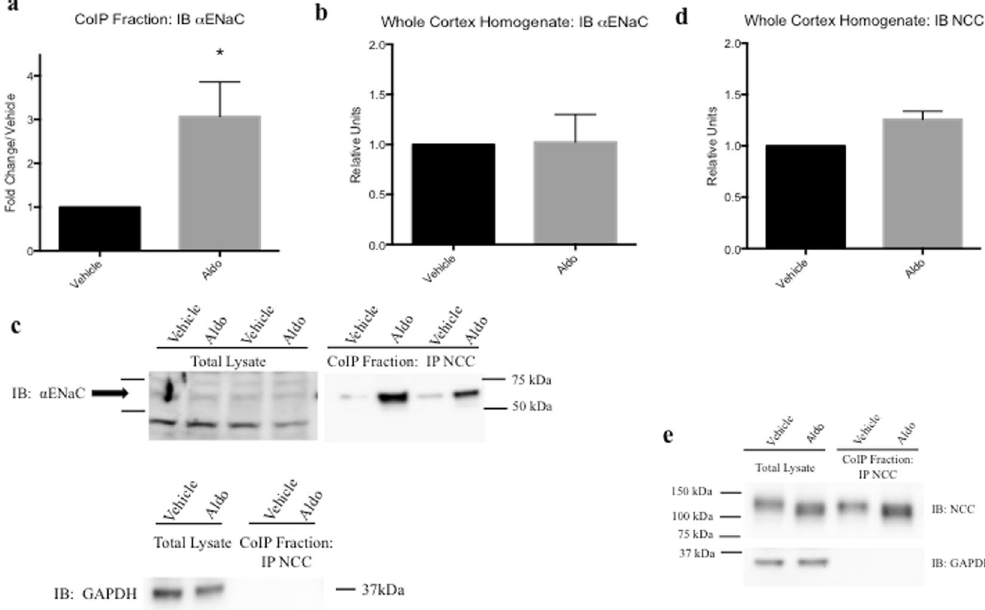
Figure 3. Coimmunoprecipitation demonstrated increased association of NCC and α ENaC aldosterone- treated mice. ( a ) Mouse kidney cortex homogenates were used and CoIP performed; CoIP fraction probed with α ENaC antibodies in vehicle (25% DMSO in saline) or Aldo-treated (4 μ g) mice for 10 days, fed high salt (4%) chow. ( b ) Whole kidney cortex lysate probed with α ENaC. ( c ) Representative blots for CoIP experiments. Blots were cut to assay for multiple antibodies. ( d ) Whole kidney cortex homogenate probed with NCC and ( e ) representative blots for NCC (lysate and and CoIP fraction) and loading control (GAPDH). Blots were cut to assay for multiple antibodies. Separation in images shown with a space. Data represented as mean ± SEM, n = 6; Wilcoxin Signed-Rank, * p < 0.05.